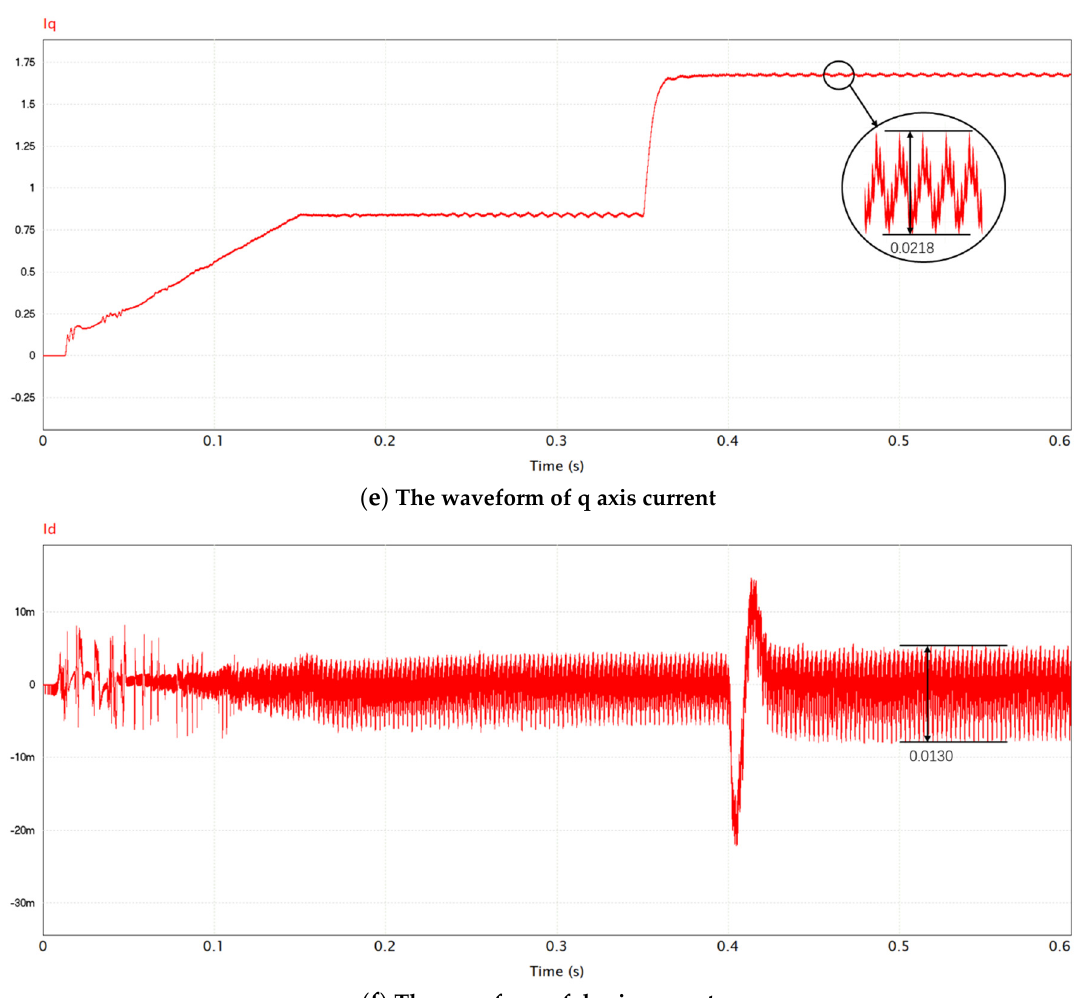
Figure 11. Simulation result of RBFNN-SMC.